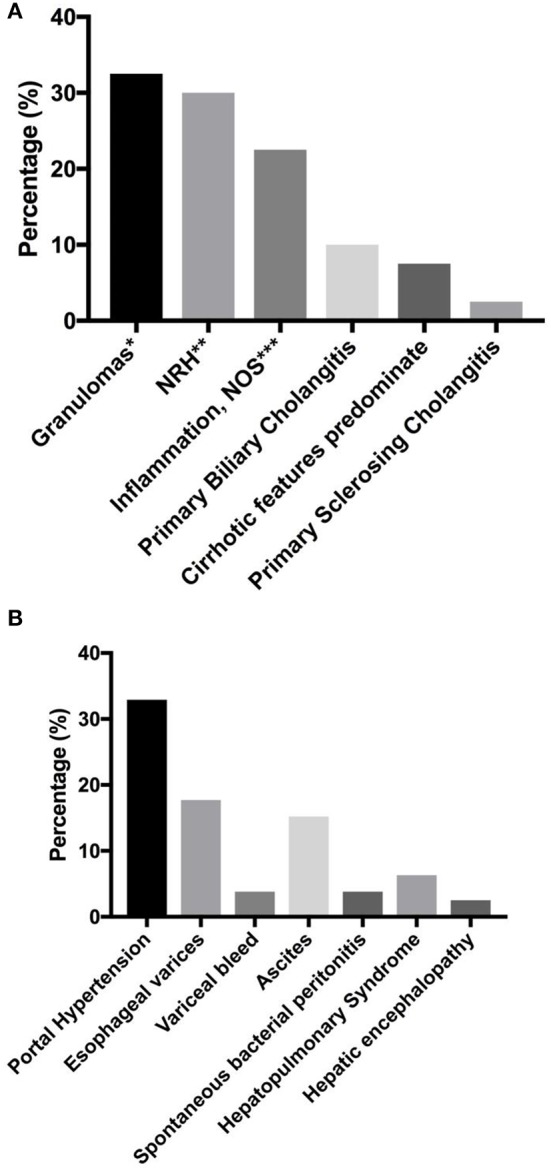
Liver disease and associated sequelae. (A) liver disease pathologies (n = 40). (B) Liver disease-associated sequelae, reported as percentage of total number of subjects with known liver disease (n = 79). *Two patients with concurrent NRH. One patient with concurrent obliterative portal venopathy specified. **One patient with concurrent obliterative portal venopathy specified. *** lymphoid infiltrates predominate in 5 patients. NRH, nodular regenerative hyperplasia; NOS, not otherwise specified.